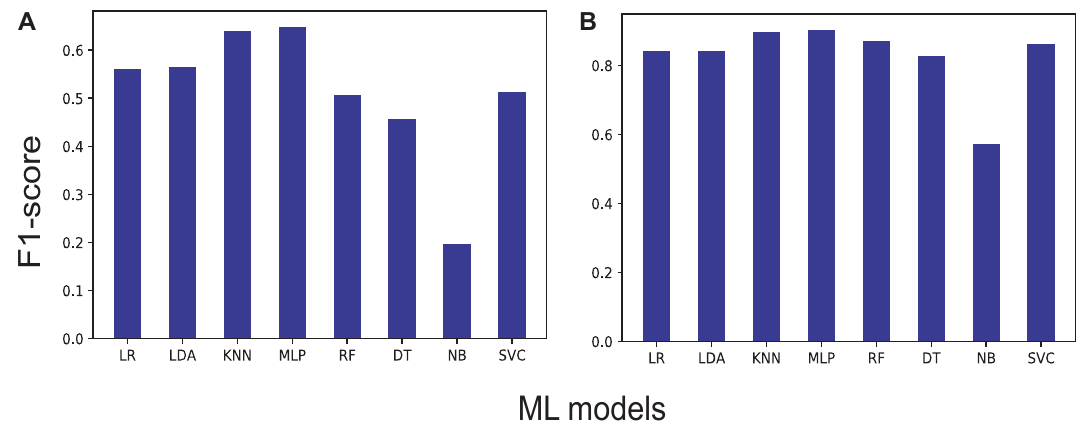
Figure 4: F1-score performance of the ML models used (A) using the five-label dataset and (B) using the two-label dataset. The following algorithms were used: KNN (K-nearest neighbors), SVM (support vector machine), LR (logistic regression), LDA (linear discriminant analysis), NB (naive Bayesian classifier), MLP (multi-layer perceptron), decision trees (DT), and RF (random